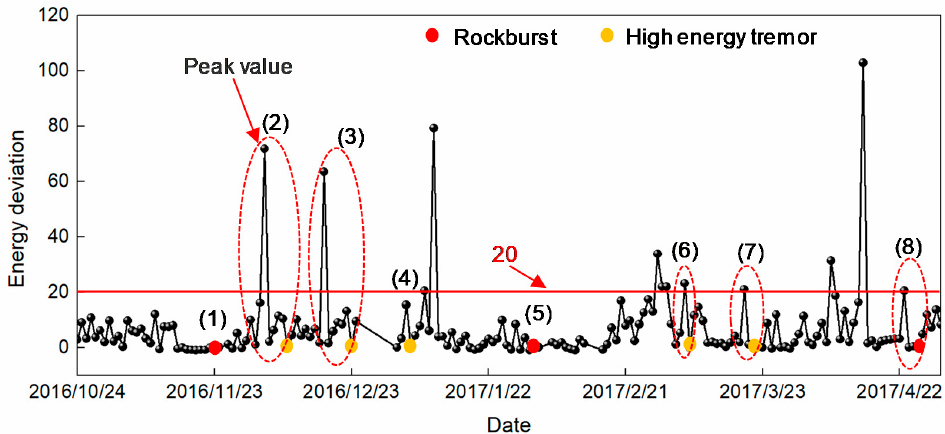
Figure 8. Energy deviation temporal evolution law before and after the rockbursts and high energy tremors.